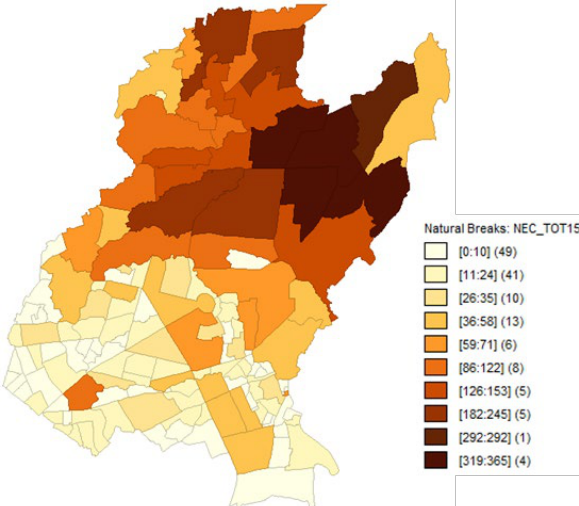
Figure 2. Total dengue cases per barangay in Quezon City in